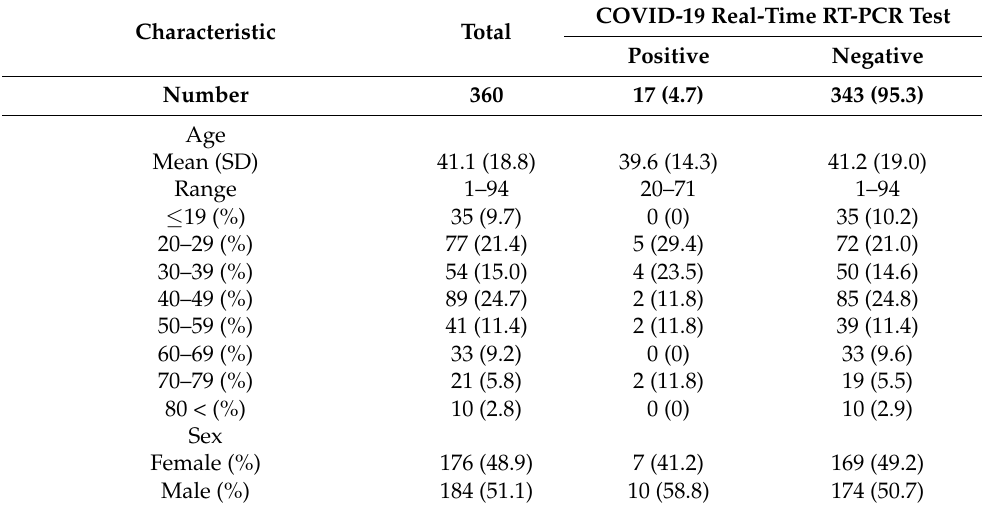
Table 1. Demographic and clinical characteristics of patients who visited the clinic and underwent COVID-19 real-time RT-PCR